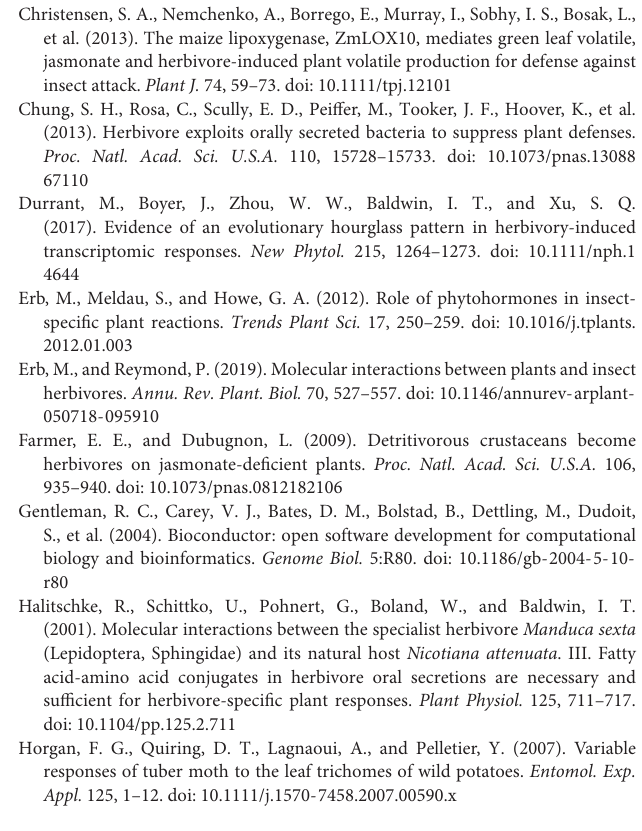
Supplementary Figure 5 | The verification of RNA-seq with quantitative real-time PCR (qRT-PCR). Four key genes ( StCOI1 , StGAL83 , StPAL1 , and StEIN3 ) that involved in potato response to insect herbivory were selected for qRT-PCR verification; these genes were upregulated or downregulated under insect herbivory. Blue bar plots (mean ± SE) represent the gene expression in RNA-seq and gray bar plots (mean ± SE) represent the gene